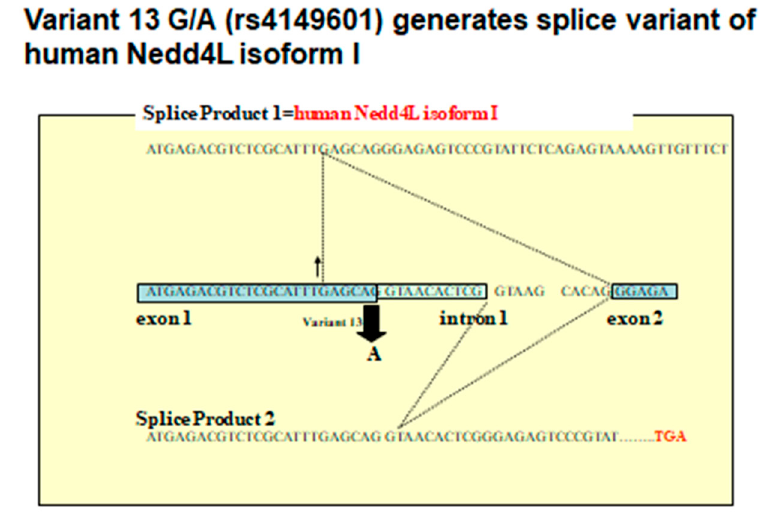
Figure 3. Detailed analyses of variant 13G / A (rs4149601) generating the splice variant of human. Nedd4L isoform I is shown. Splice site moves 10 base pairs and splice product 2 ends in the stop codon in exon 2.(modified from [45])